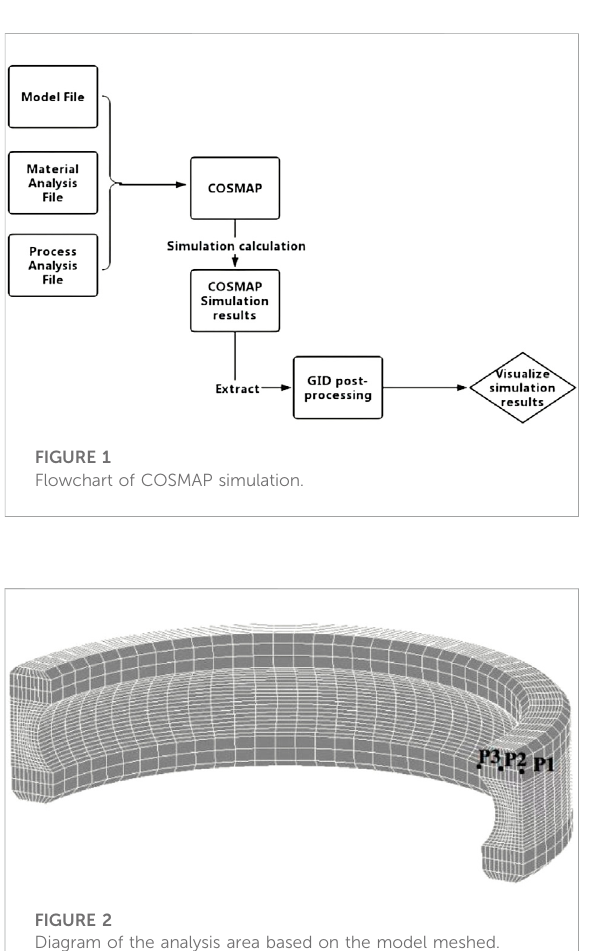
FIGURE 2 Diagram of the analysis area based on the model